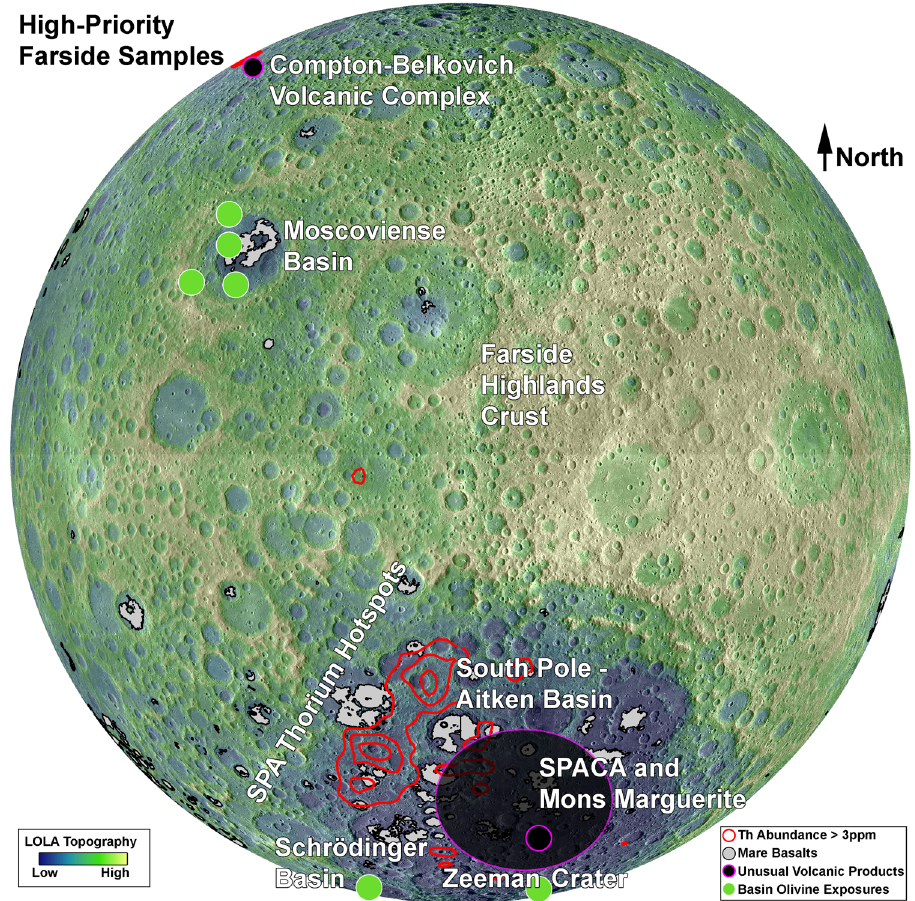
Fig. 3 The distribution of high-priority sample targets materials on the currently-unsampled lunar farside. A high concentration of such materials is found within the South Pole – Aitken Basin (SPA) in the southern hemisphere, including the high-Th mantle ejecta and unusual volcanic province referred to as the SPA Compositional Anomaly (SPACA). Crustal materials are widely available across the farside highlands, and low-Ca pyroxenes are observed within many large impact structures. These samples may be available for return to Earth via NASA ’ s Artemis Program, especially if robotic or other surface assets are able to transport samples from SPA to the Artemis site around the lunar South